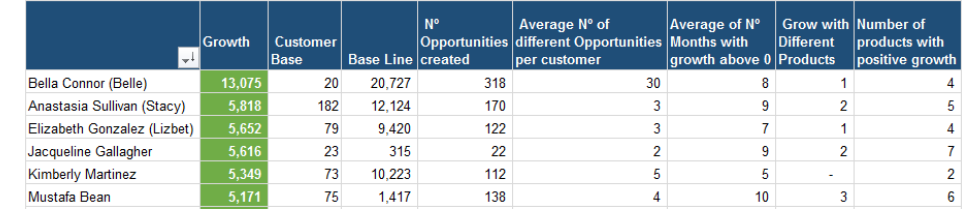
Figure 4. Other relevant KPIs for 5 salespeople sorted by